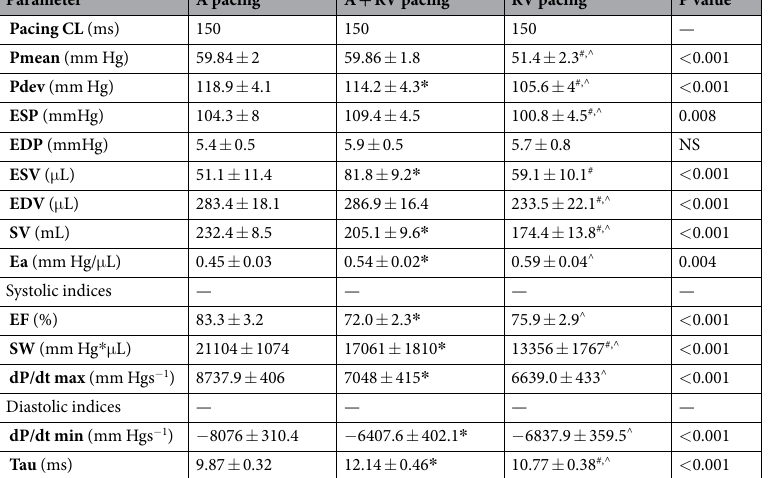
— — — < 0.001 SW (mm Hg * μ L) 21104 ± 1074 < 0.001